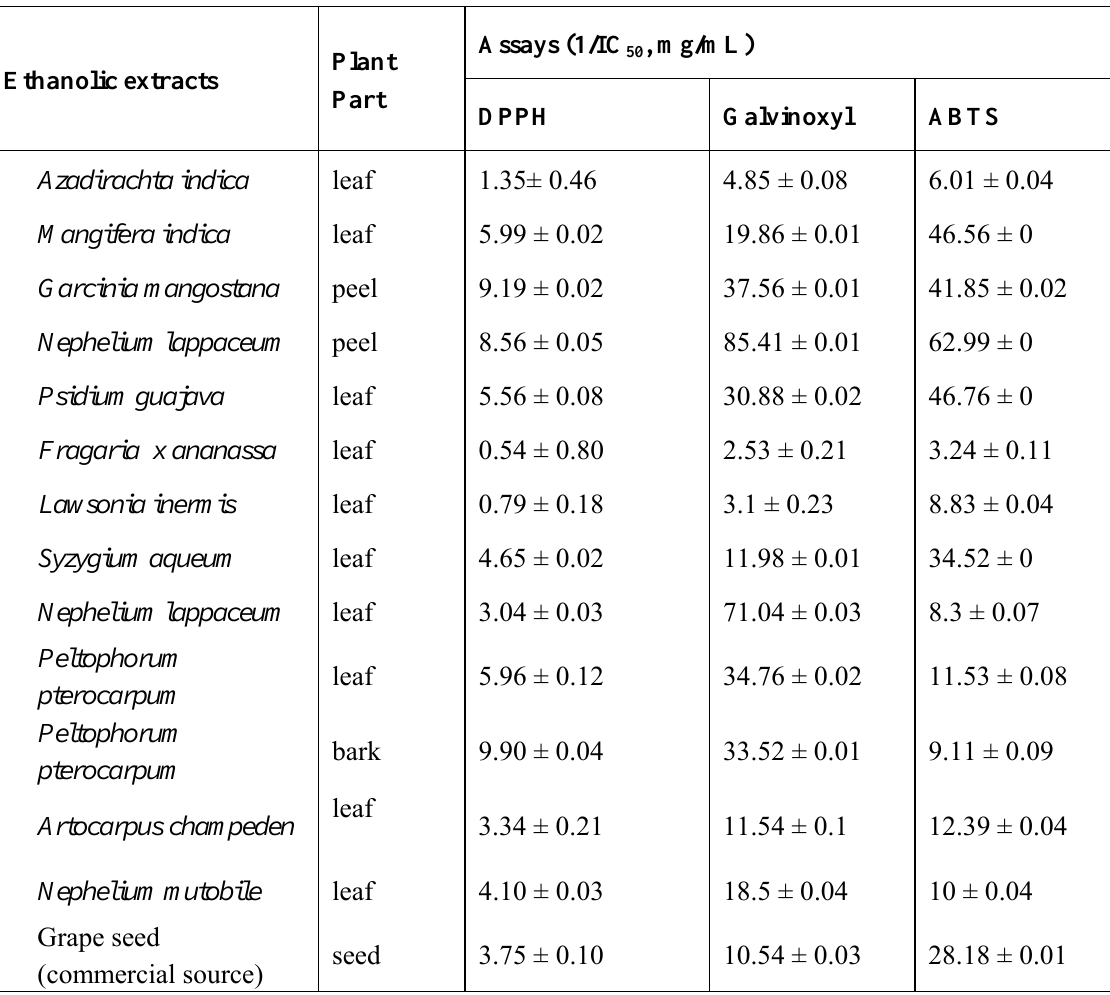
Table 2. Free radical scavenging activity of various Malaysian plants extracts in ethanol.